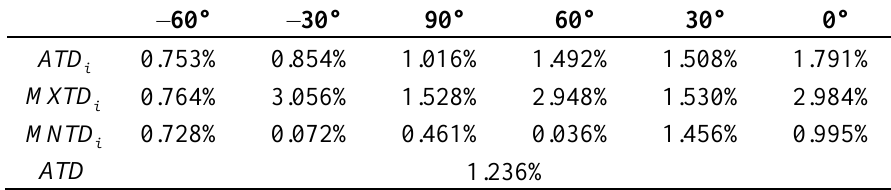
Table 6. Quantitative experimental results for straight line detection angle